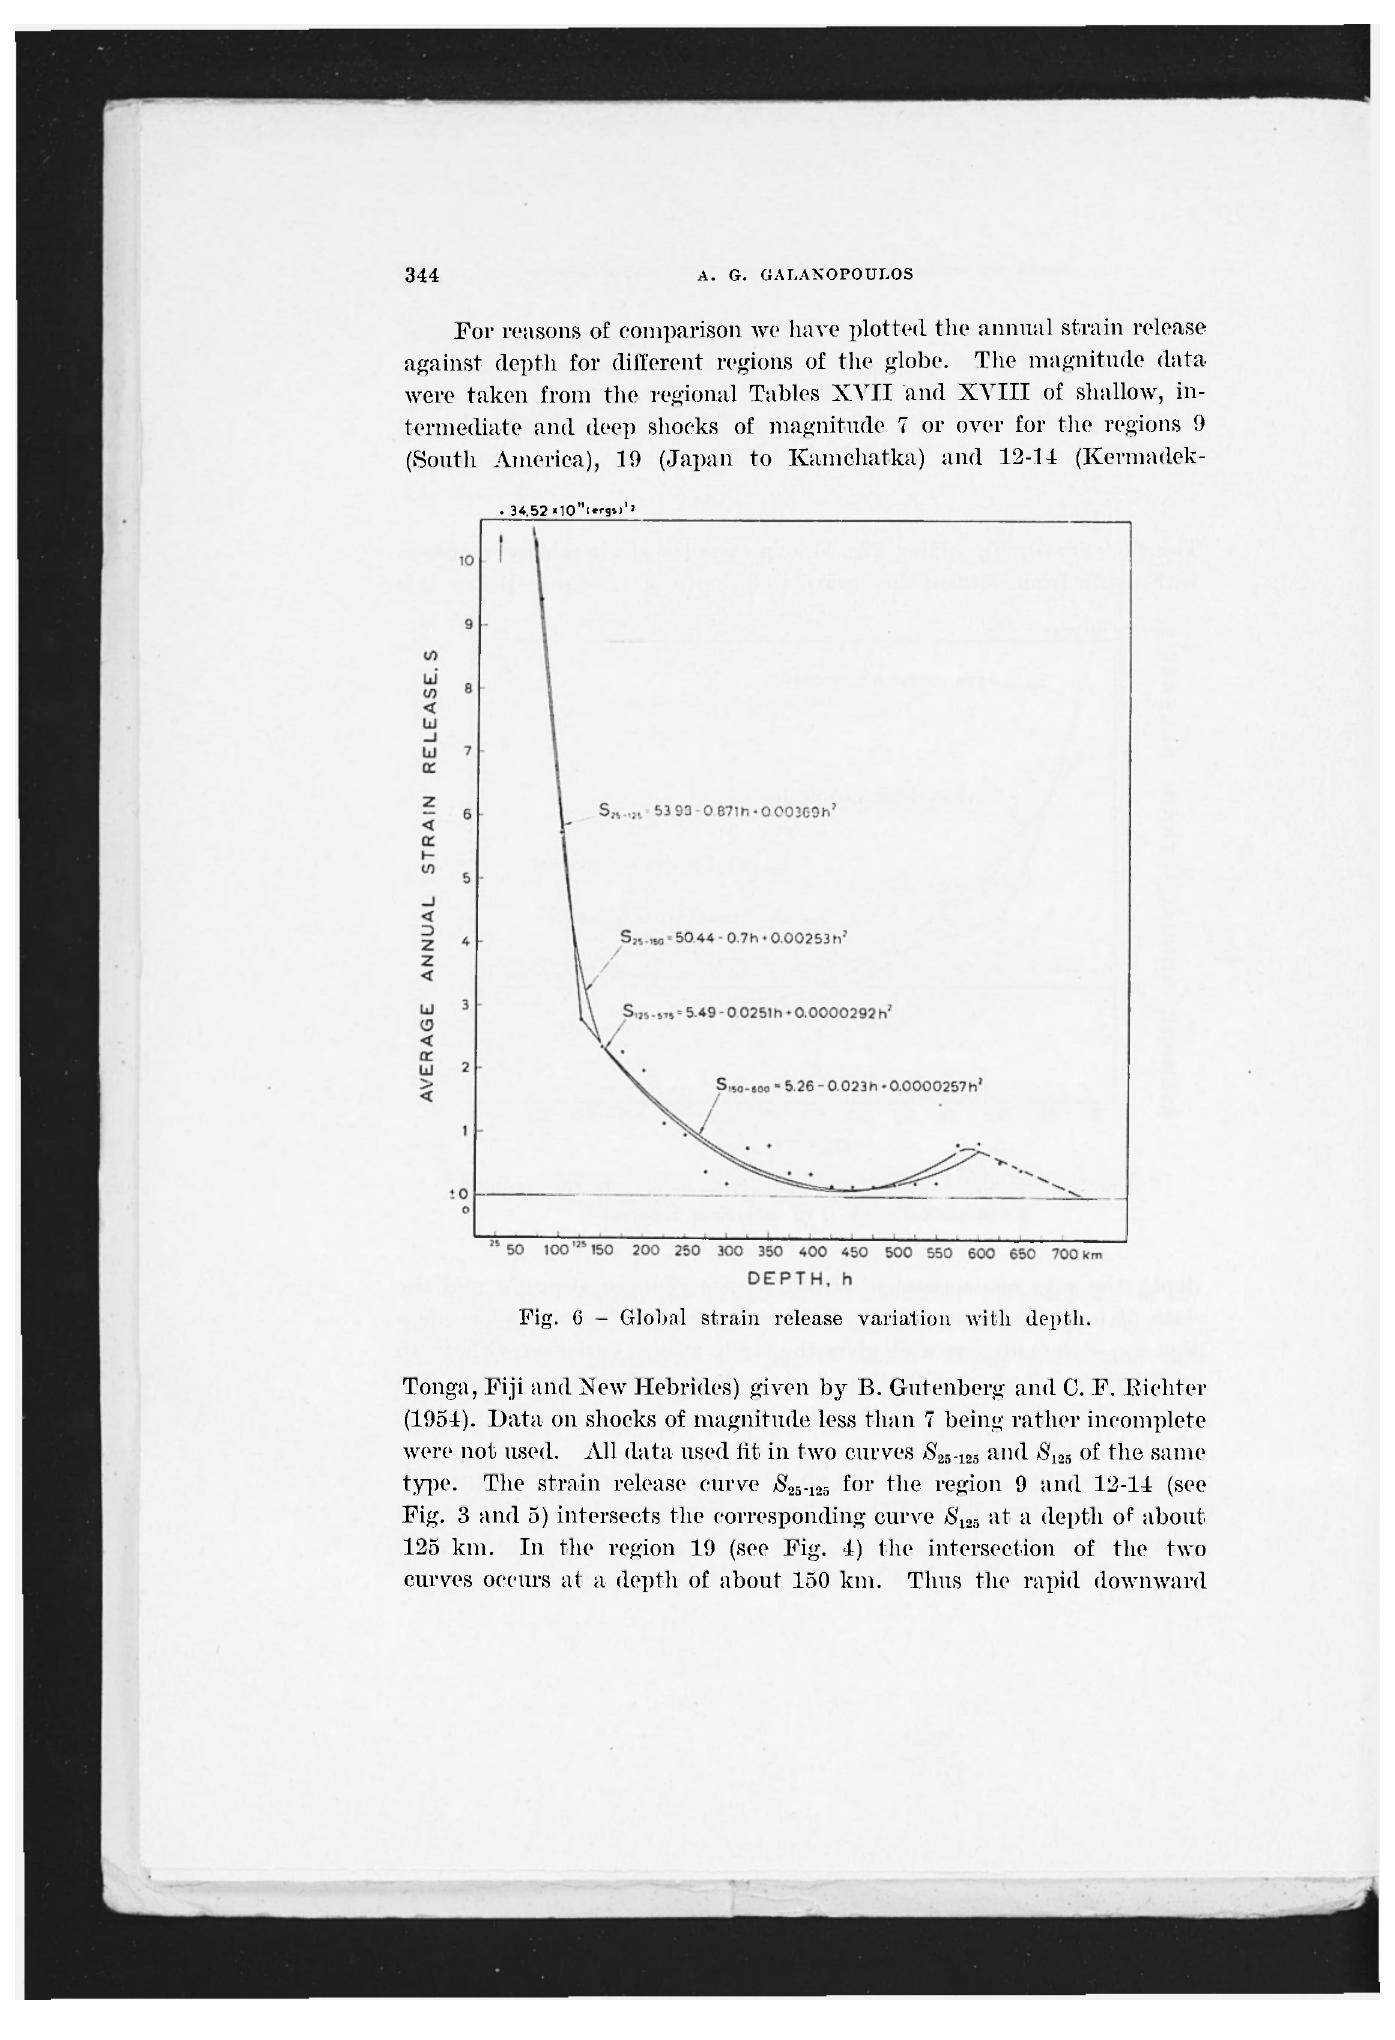
Fig. 6 - Global strain release variation with